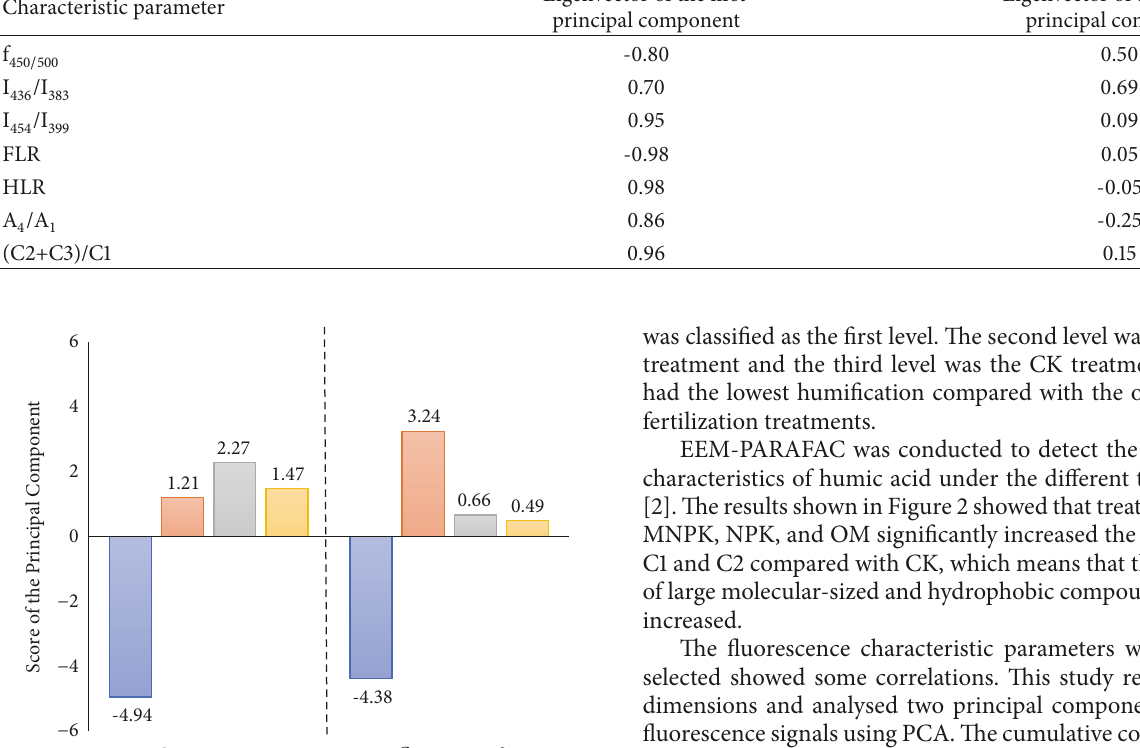
Table 3: Contributions of characteristic fluorescence parameters to eigenvectors of the first two principal components. Characteristic parameter